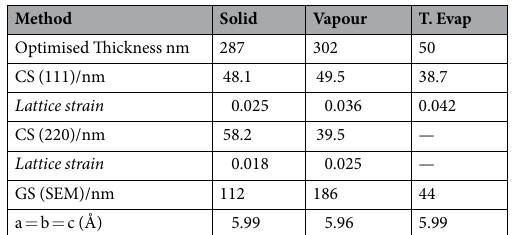
Table 1. Crystallite (CS) and grain (GS) sizes obtained by the three methods used. Lattice strain values were calculated considering peak broadening due to microstrain ( ε ) as: B(2 θ ) = 4 ε (sin θ /cos θ ) using the FWHM 25 .